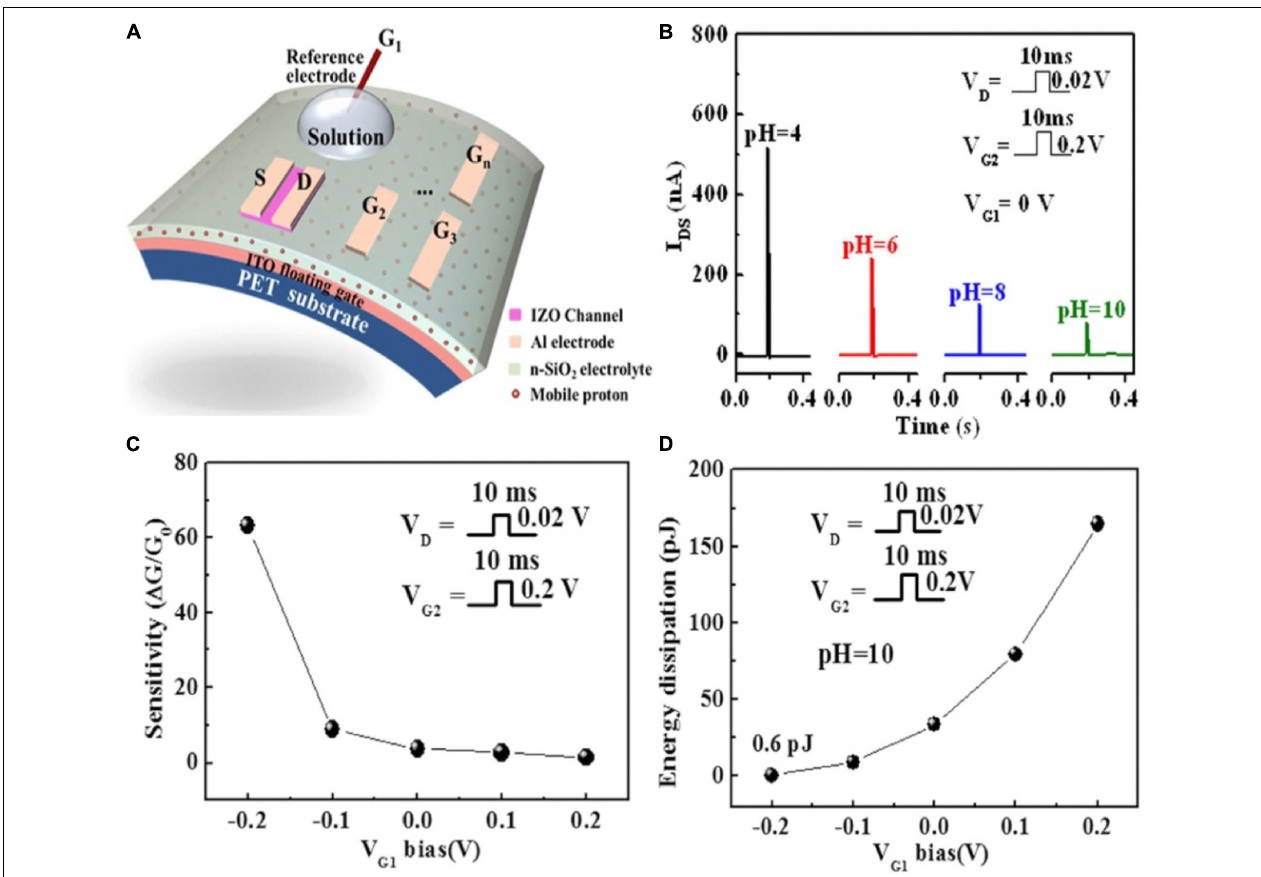
FIGURE 14 | (A) Schematic of the pH-sensing IZO-based synaptic transistor. (B) The change of current with pH value. (C) The change of sensitivity with V G 1 bias (pH = 10). (D) The change of energy dissipation with V G 1 bias (pH = 10) (adapted from Liu N. et al., 2015).